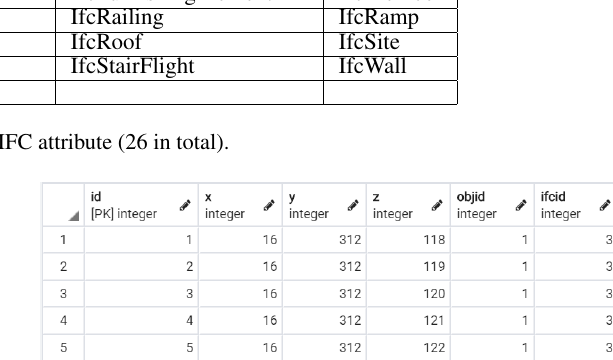
Figure 1. Example of a table created in PostgreSQL to store ARRAY